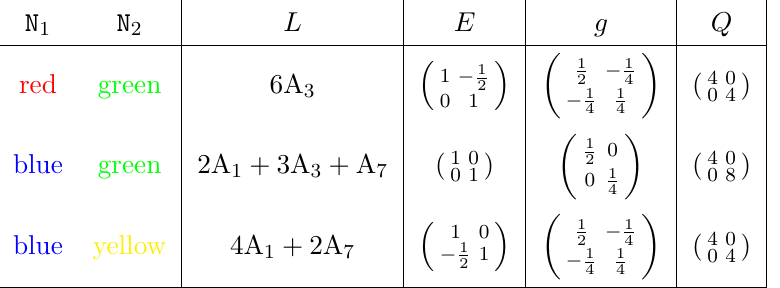
Table 8. Three maximal enhancement points for the Wilson lines given in (5.32) and di(cid:11)erent val- ues of E . The torus metric g and the Gram matrix Q of the complementary lattice T are also given. N 1